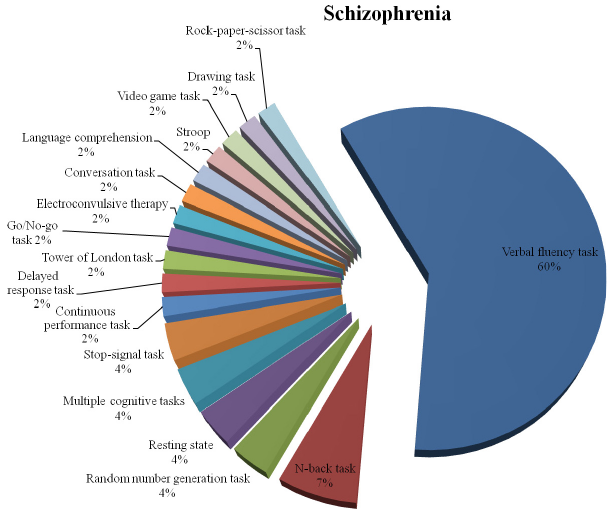
Fig. 6. Task-based distribution of studies on schizophrenia (total studies: